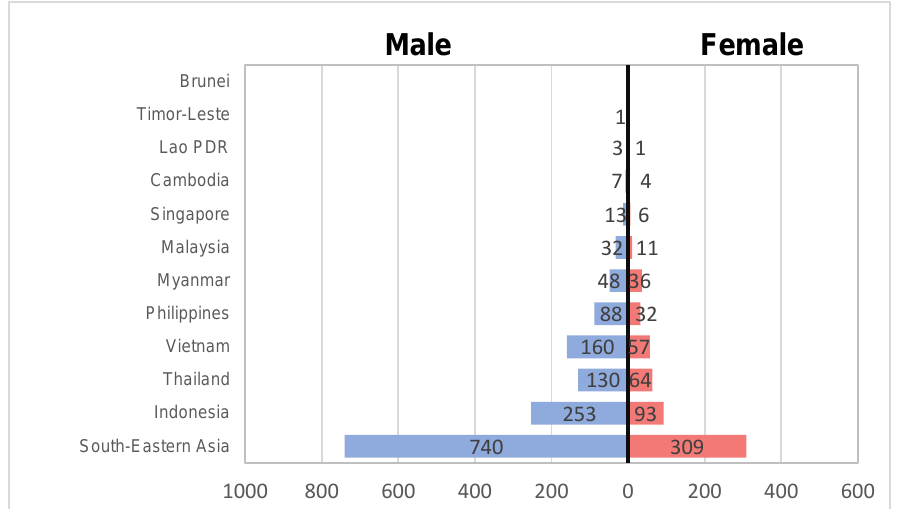
Figure 1. Lung cancer incidence in Southeast Asia (Estimated numbers x 100). Source: GLOBOCAN (IARC).